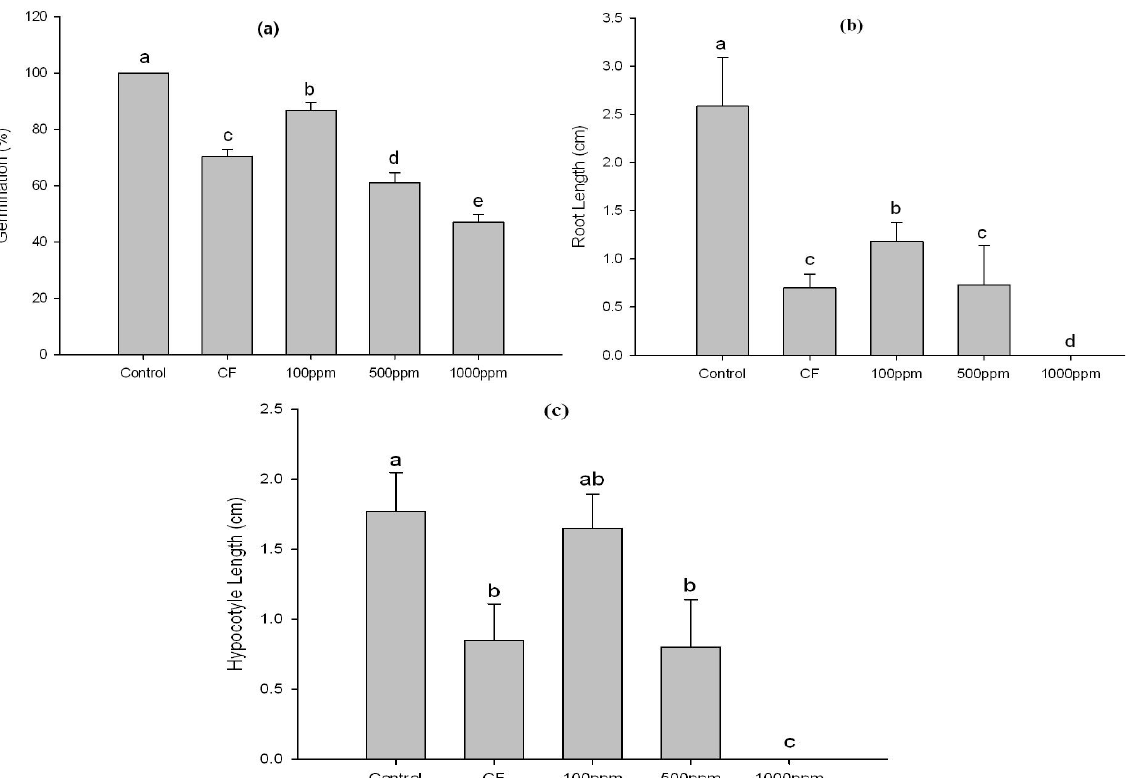
Figure 1. Assessment of Cladosporium cladosporioides LWL5 culture filtrate (CF) and its ethyl acetate extract (100, 500, 1000 ppm) on lettuce seed germination ( a ) root length ( b ) and hypocotyl length; and ( c ) Control was treated with distilled water. Different letters on bars indicates significant difference at ( p < 0.05) among treatments as evaluated by Duncan’s Multiple Range Test (DMRT). Error bars represents the standard deviation ( n =